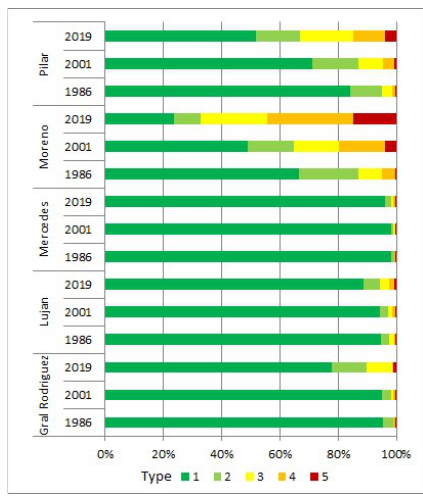
Figure 6. Built-up areas based on urban regimes The municipalities with the greatest variability and diversity of urban regimes are Moreno and Pilar. The proportion of the compact or consolidated regime (Type 5) in Moreno has increased from 0.5% to 14.6% and its zones with dispersed constructions (Type 1 and 2) have decreased from 86.8% to 32.8%. In addition fast-growing areas with metastatic consolidation (Type 4) have increased from 4.6% to 29.8%. In the case of Pilar, dispersed constructions have predominated at all times (from 95.0% to 66.7%). Although its compact zones represent less than 4.0% yet, a growth of the type 4 urban regime zones (from 0.7% to 10.7%) is detected. According Encarnação (2012) types 3 and 4 are the regions where